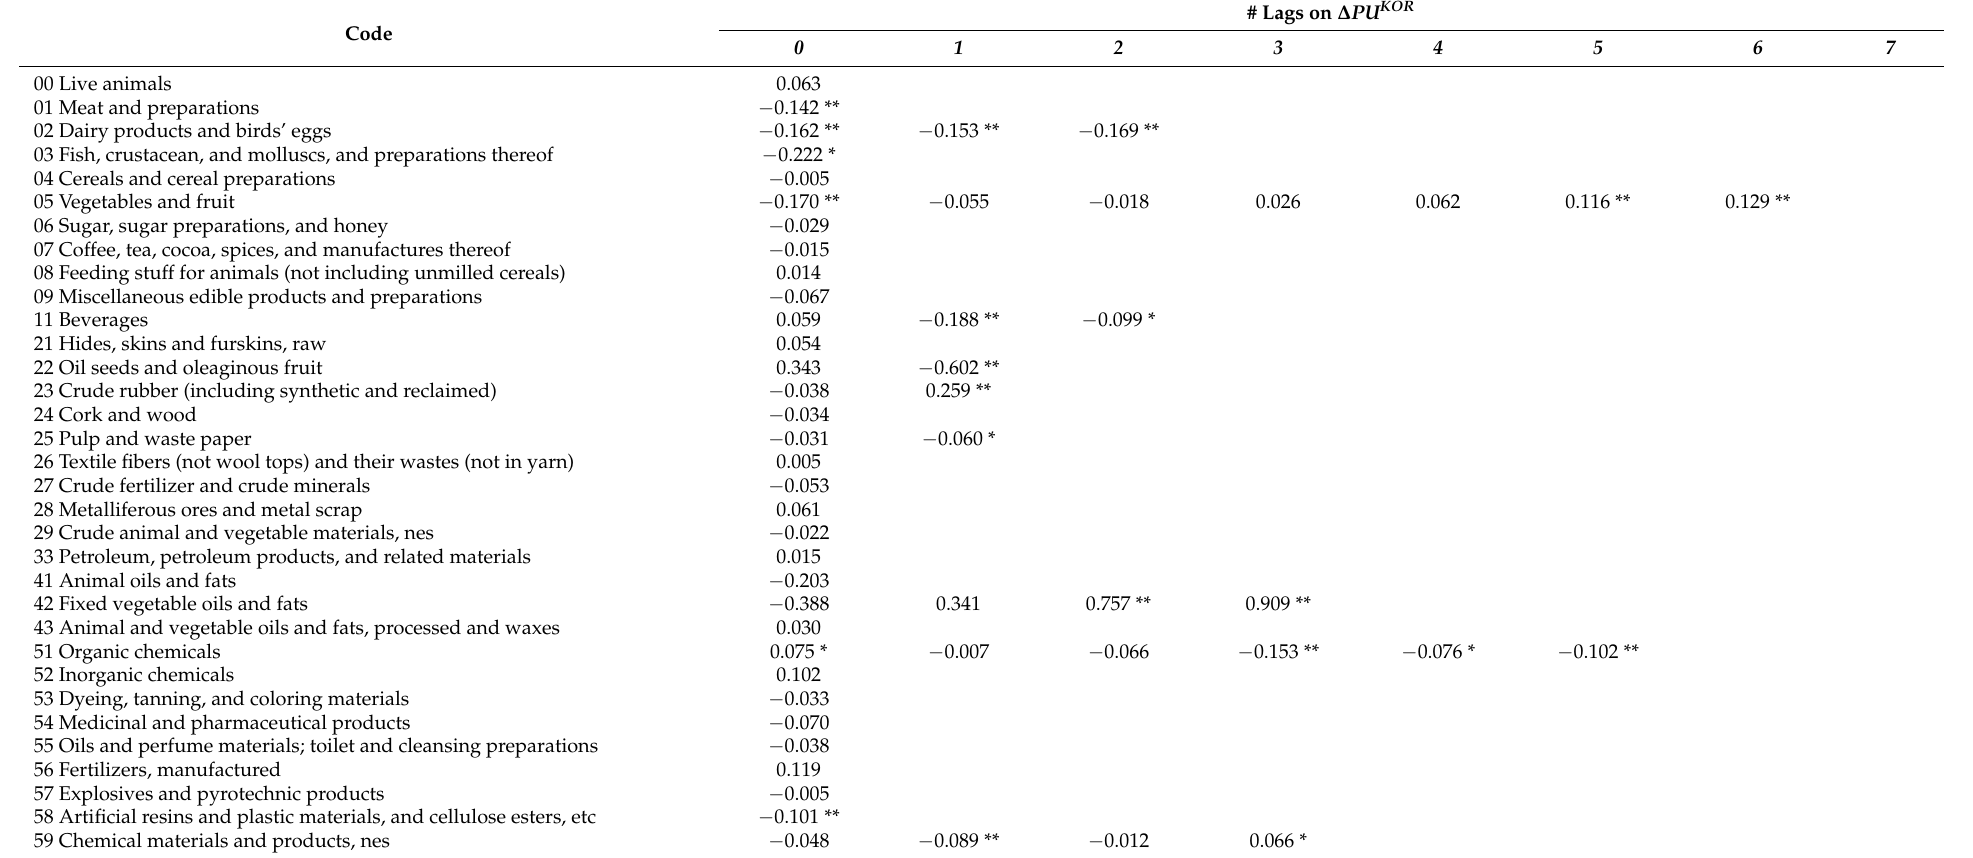
Table 1. Short-run coefficient estimates of Korean economic uncertainty on U.S. exports to